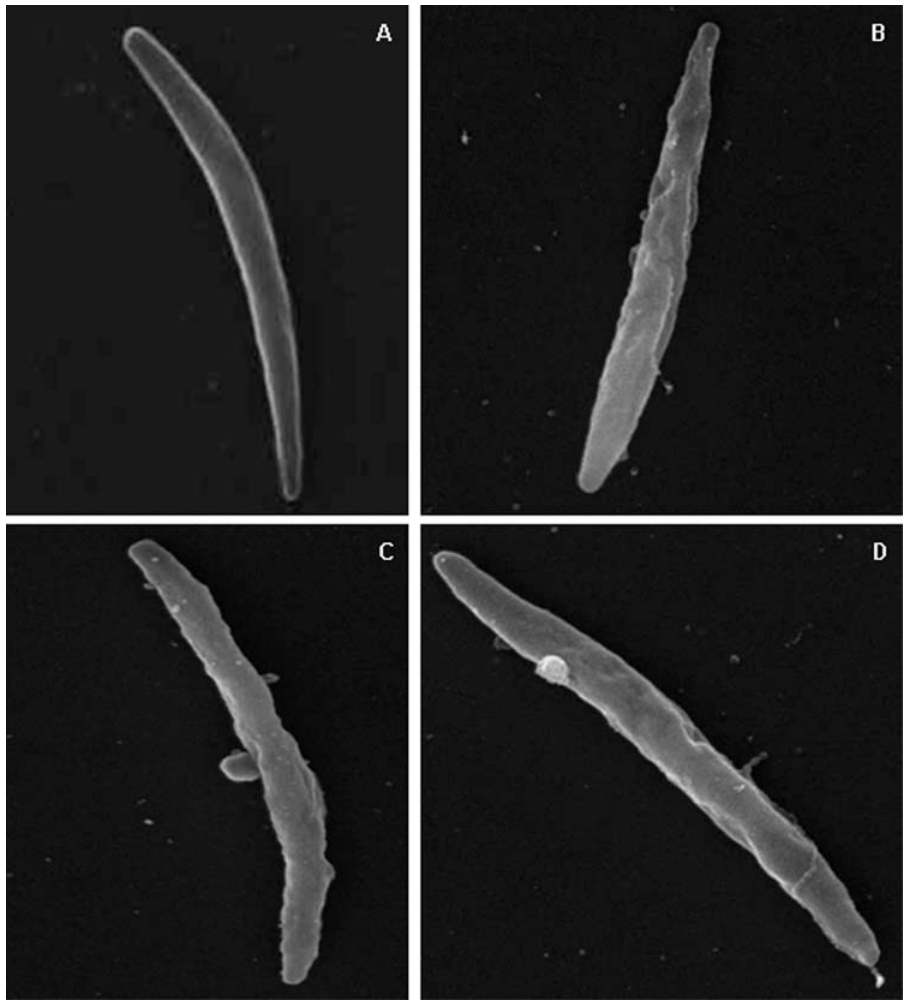
Figure 3. Scanning electron microscopy of salivary gland-derived P.gallinaceum sporozoites. Parasites were incubated with PBS (A, control), angiotesin II (B) and VC5 (C and D). Note the smooth surface of the non-treated sporozoites (PBS-control) with the rough surface of the drug- treated parasites (ANG II and VC5).